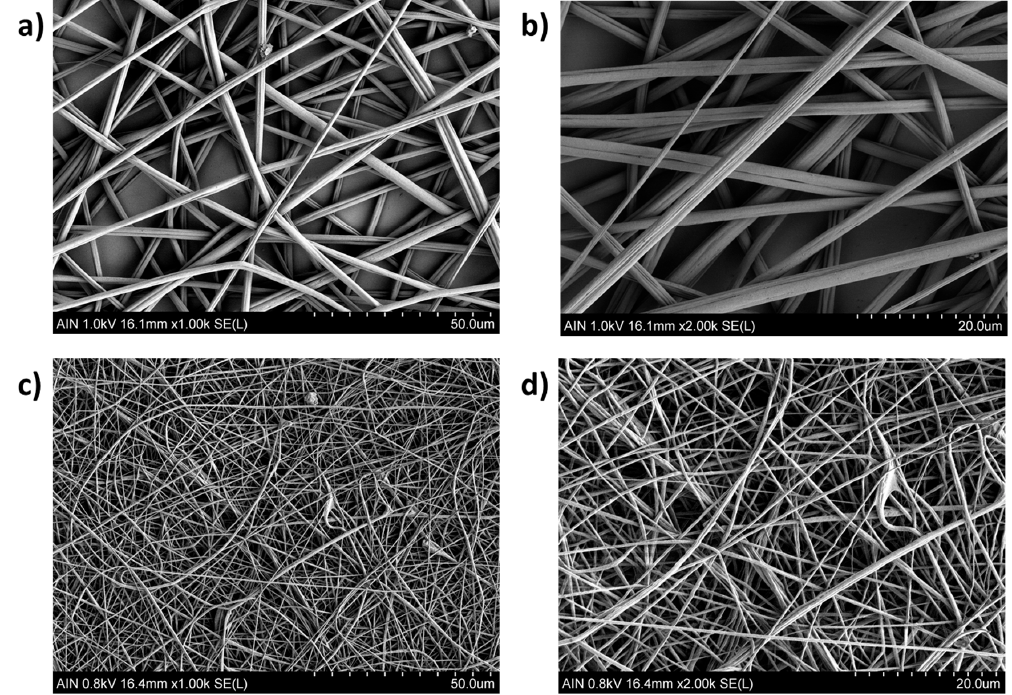
Figure 12. SEM images of the PS electrospun fibres ( a , b ) and PVC electrospun fibres ( c , d ) at different scale bar. Reprinted with permission of [73].